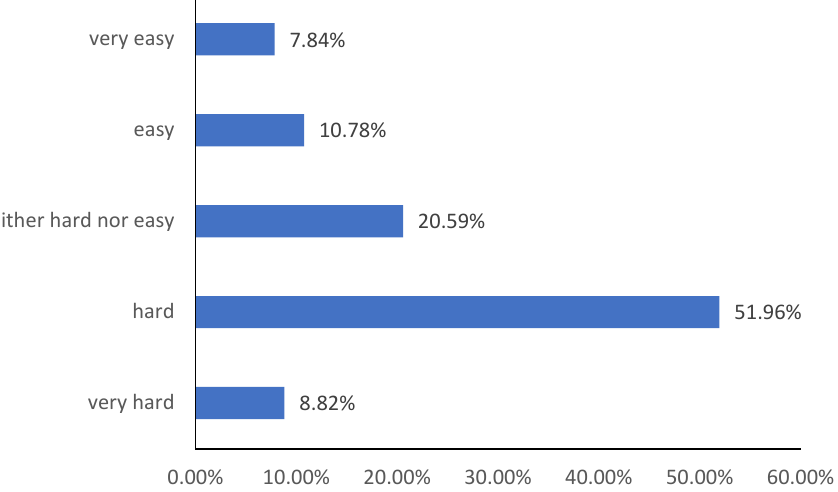
Figure 1. The way in which the transition from the standard to the remote form of work was carried out.